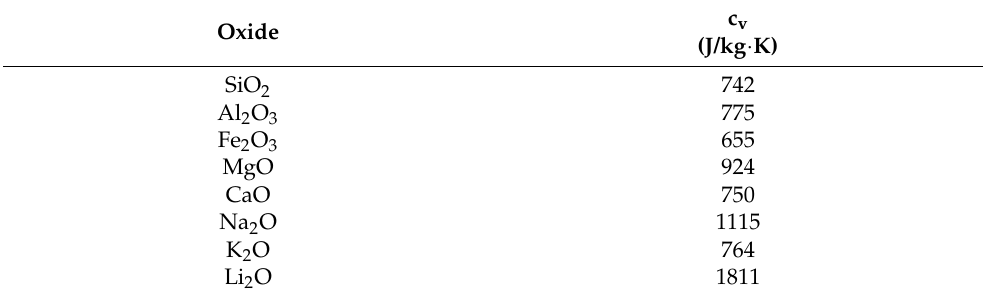
Table 3. Tabular-specific heat.